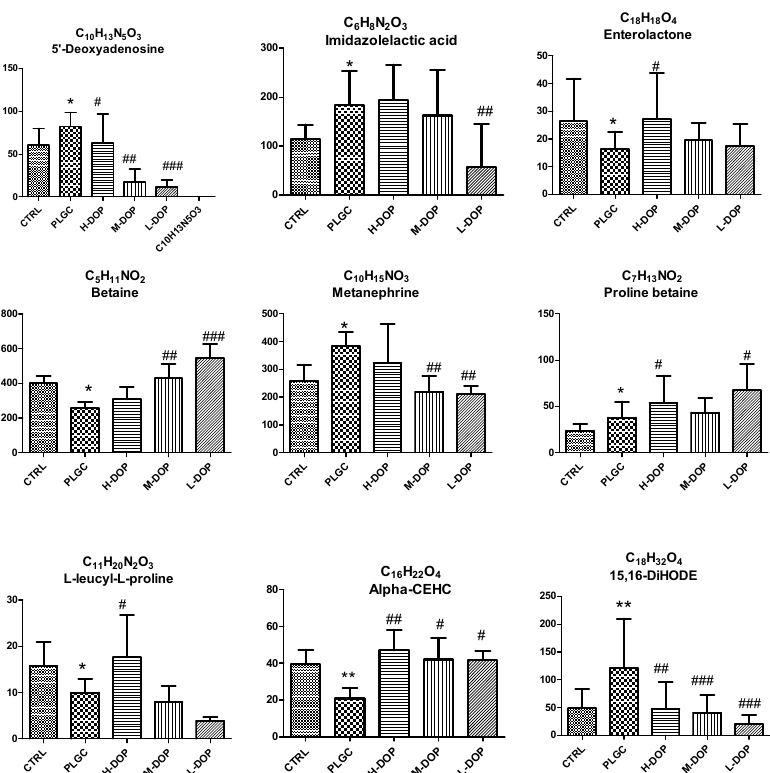
Figure 5. The effect of DOP on height values of nine changing endogenous metabolites in each group under positive and negative ion mode. Results from administering DOP 7 months on PLGC rat model: the compound was analyzed in the serum by UPLC / Q-TOF-MS and then selected variables with a VIP > 1.0 and p < 0.05 and that compound was regarded as potential biomarkers for further statistical analysis. Statistical analyses were carried out by using one-way ANOVA and Tukey post-hoc test. * p < 0.05, *** p < 0.001 vs. the CTRL; # p < 0.05, ## p < 0.01 and ### p < 0.001 vs. the PLGC model.